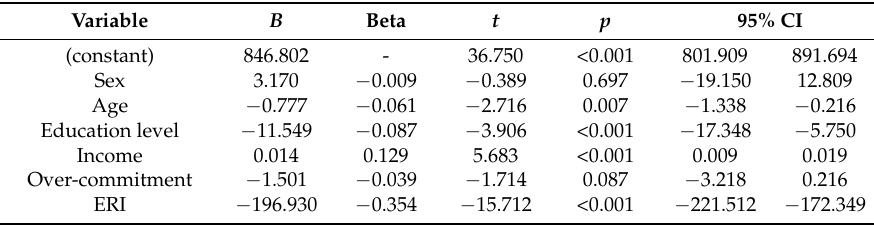
Table 7. The effects of quality of life -related factors among copper-nickel miners according to the results of the multiple linear regression